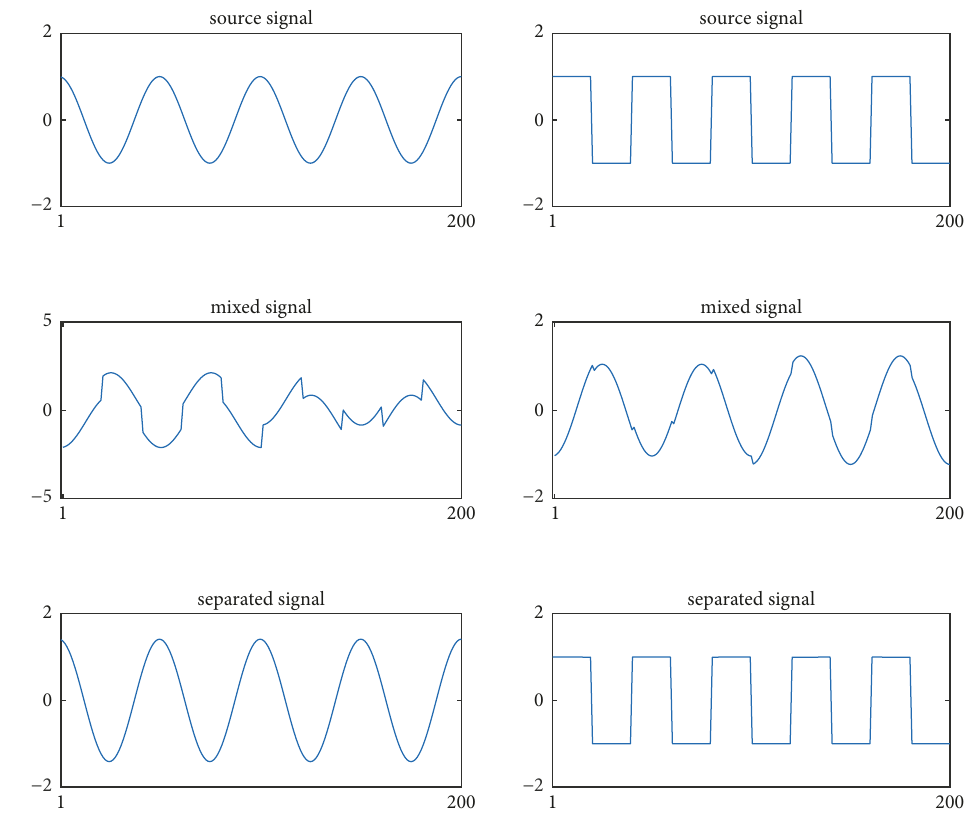
Figure 2: The decoupling of cosine signal and square wave